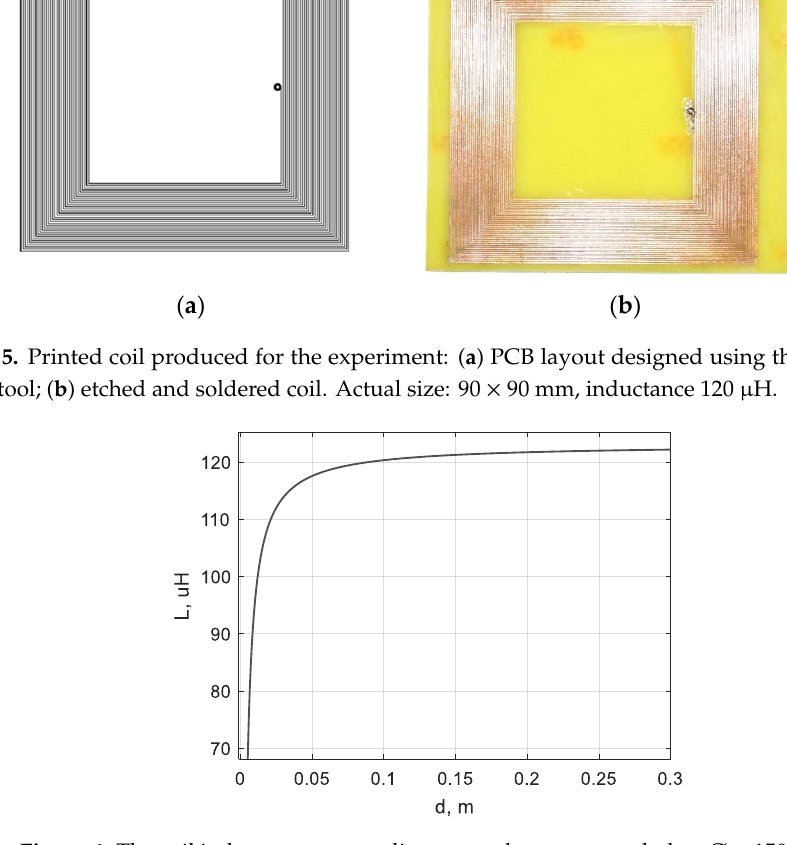
Figure 6. The coil inductance versus distance to the target; steel plate Ø = 150 mm.